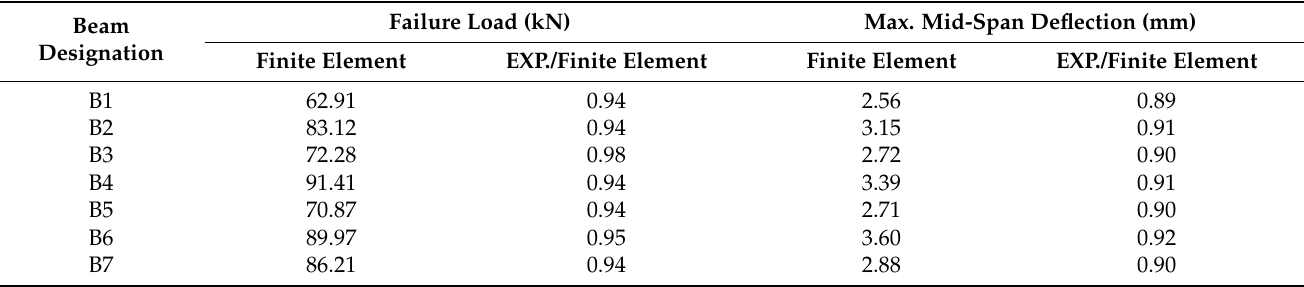
Table 7. Comparison between the experimental and finite element